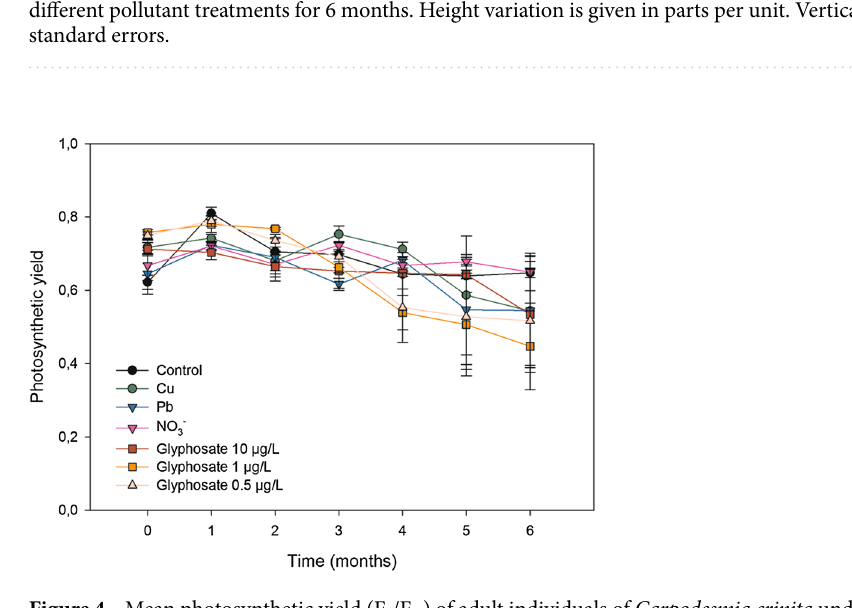
Figure 4. Mean photosynthetic yield (F v /F m ) of adult individuals of Carpodesmia crinita under control conditions and the different pollutant treatments for 6 months. Vertical bars represent standard